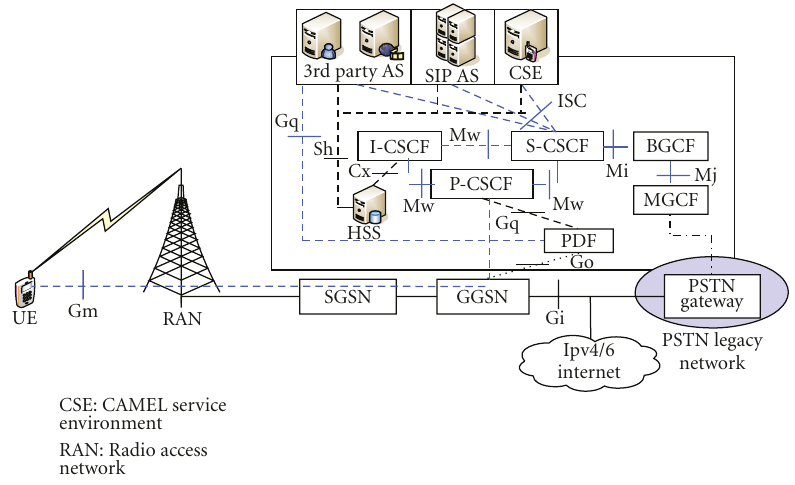
Figure 1: 3GPP IMS